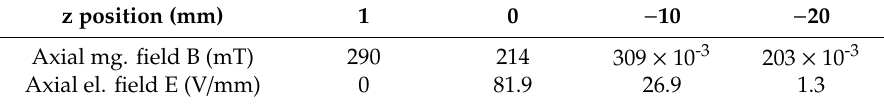
Figure 2. Axial electrostatic and magnetic field; WD = 1 mm, E P = 1 keV, sample plane z = 1 mm. Table 1. Axial intensity of the magnetic (B) and the electrostatic fields (E) in z position; WD = 1 mm, E P = 1 keV.